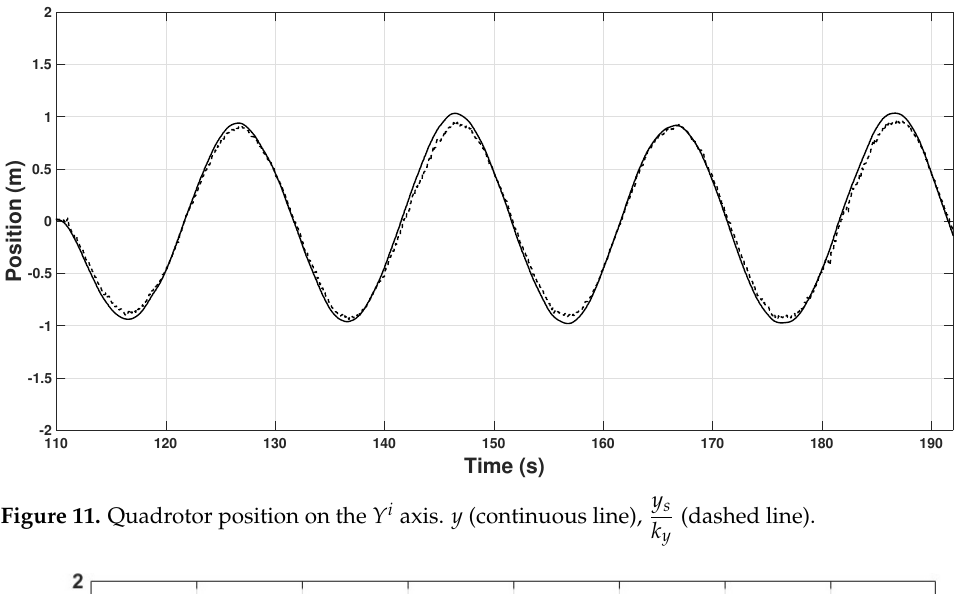
Figure 11. Quadrotor position on the Y i axis. y (continuous line),